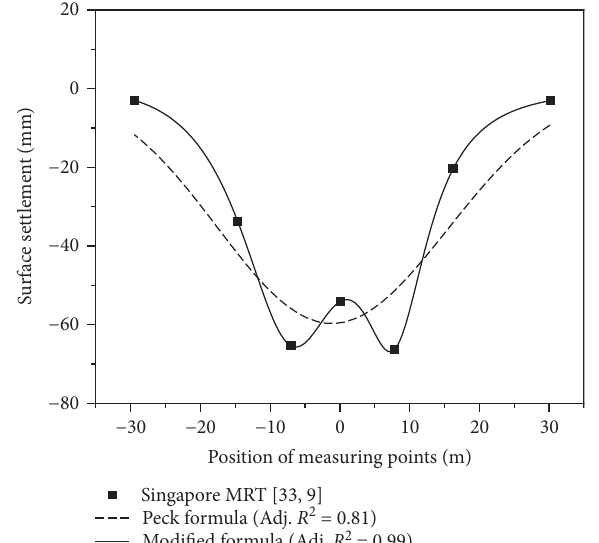
Figure 15: Surface settlement of Singapore MRT.